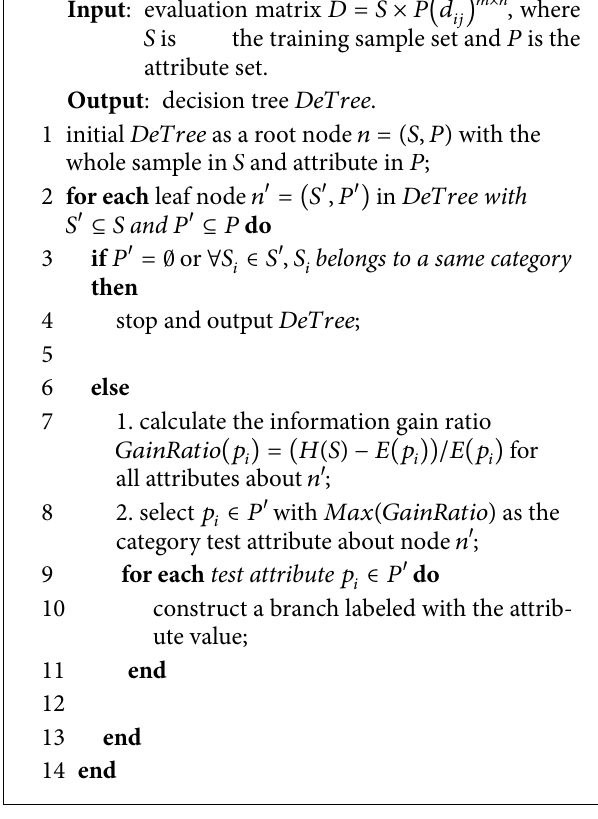
Algorithm 2: C4.5: decision tree construction